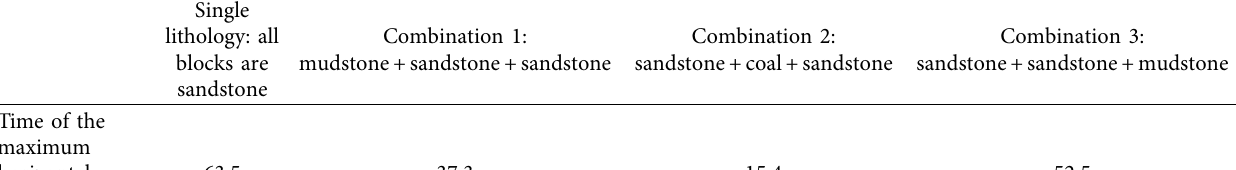
Table 7: Time of the maximum horizontal displacement amplitude and stabilization time of displacement amplitude fluctuation of the working block under different lithology.